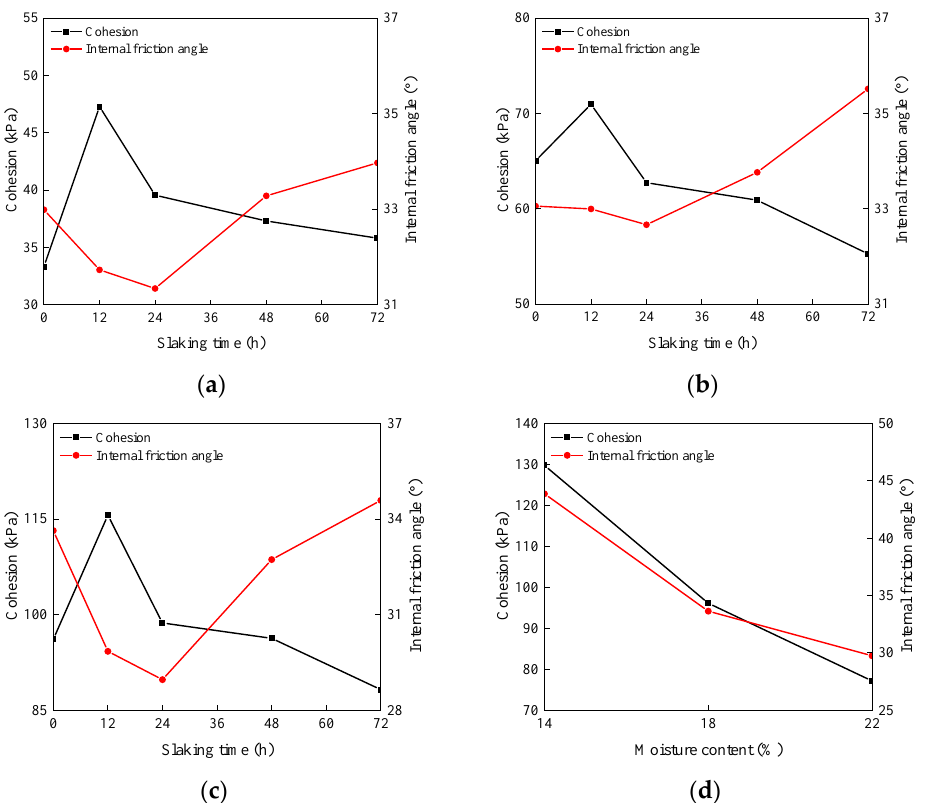
Figure 8. Relation curve between cohesion and internal friction angle of specimens: ( a ) M = 10%, W = 18%; ( b ) M = 15%, W = 18%; ( c ) M = 20%, W = 18%; ( d ) T = 0 h, M = 20%.